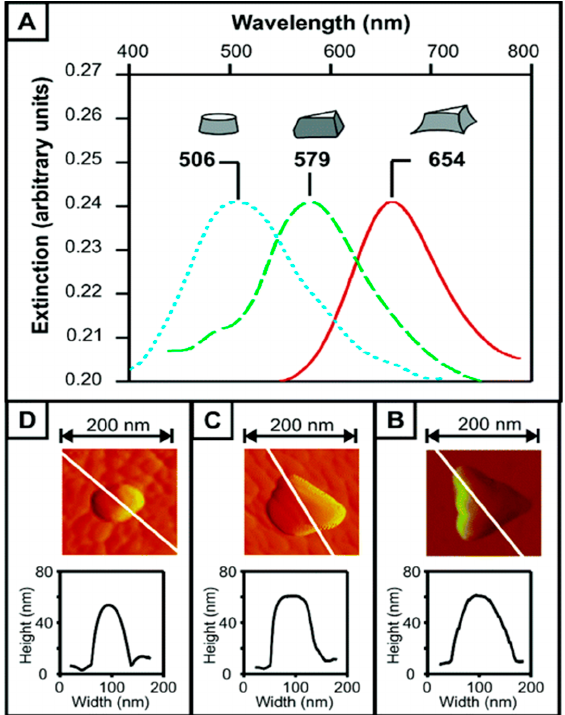
Figure 6. Shifting of the localized surface plasma resonance (LSPR) absorption bands following the shape modification of silver nanoparticles (NPs) (reproduced from [57] Copyright (2005) American Chemical Society). ( a ) Towards shorter wavelengths after subsequent chronocoulometry measurements; ( b ) Atomic-force-microscope image following two chronocoulometry runs, ( c ) following one chronocoulometry run ( d ) before any electrochemical